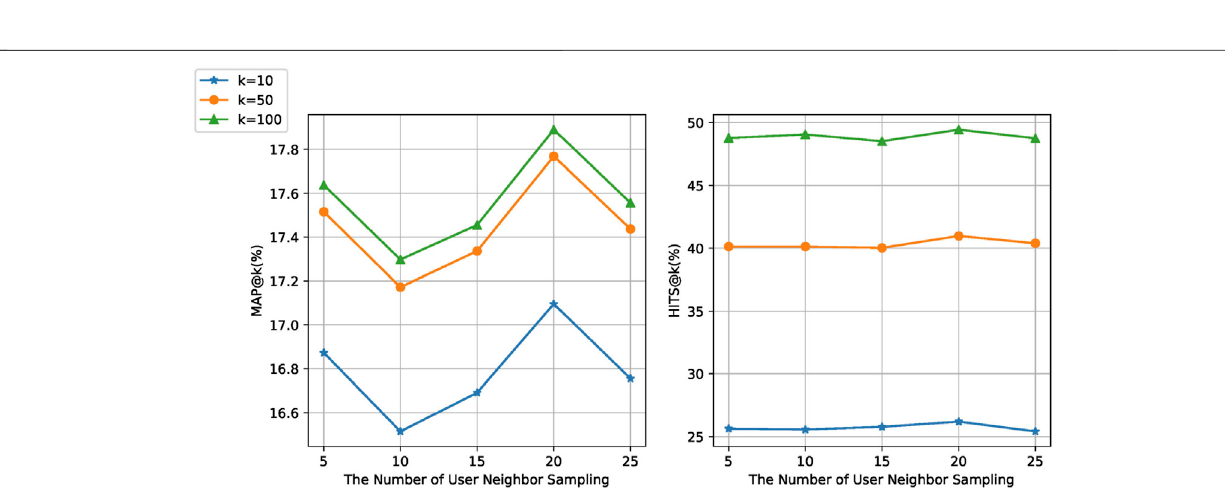
Frontiers in Physics |